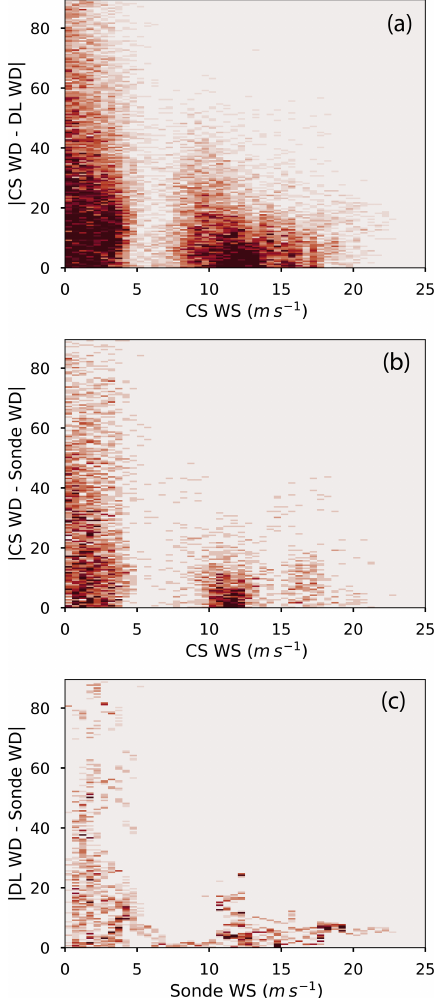
Figure 6. Two-dimensional histograms of absolute wind direction difference vs. wind speed for the CopterSonde and DL (a) , Copter- Sonde and radiosonde (b) , and DL and radiosonde (c) . This shows that the lower wind speed measurements have a higher level of uncertainty in the wind direction. Again, the distribution is bi- modal, with LAPSE-RATE observations all generally falling below 5ms − 1